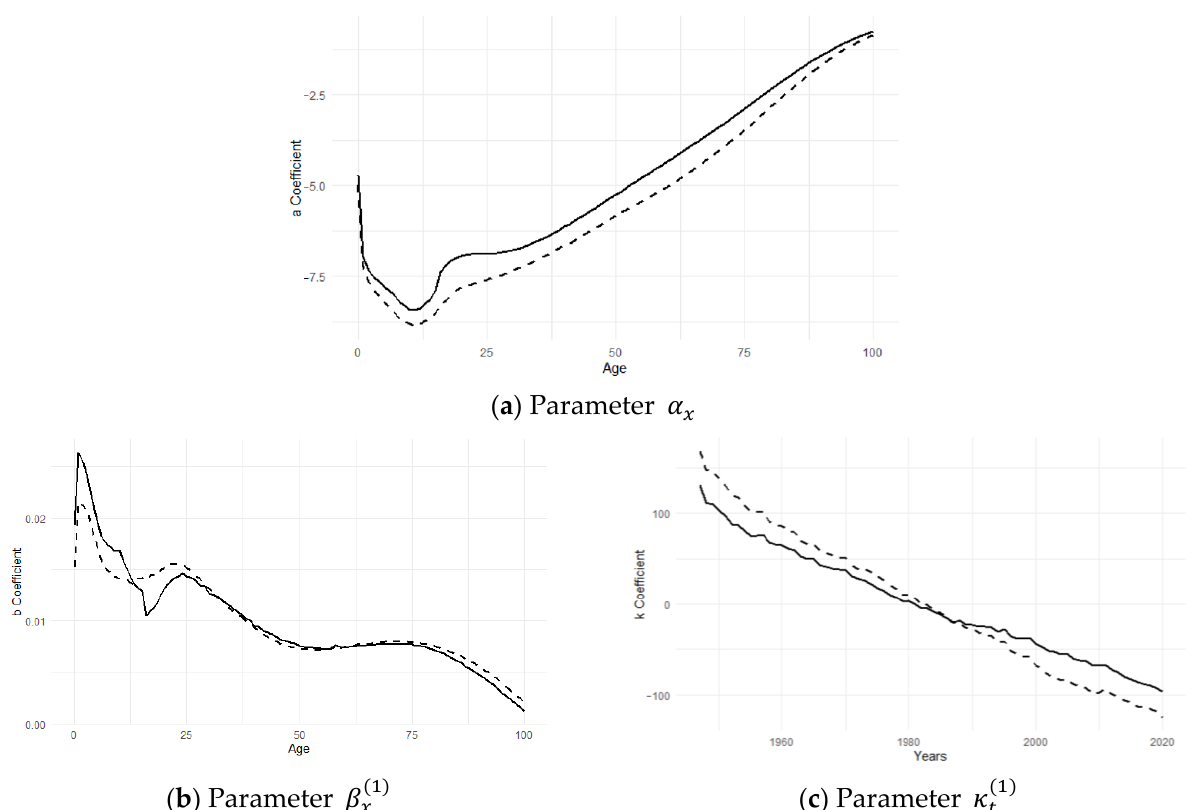
Figure 3. Japan’s LC model for both males (solid line) and females (dashed line).